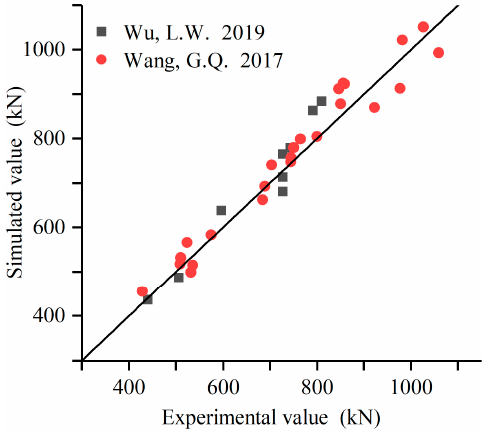
Figure 13. Comparison of simulated and experimental values.